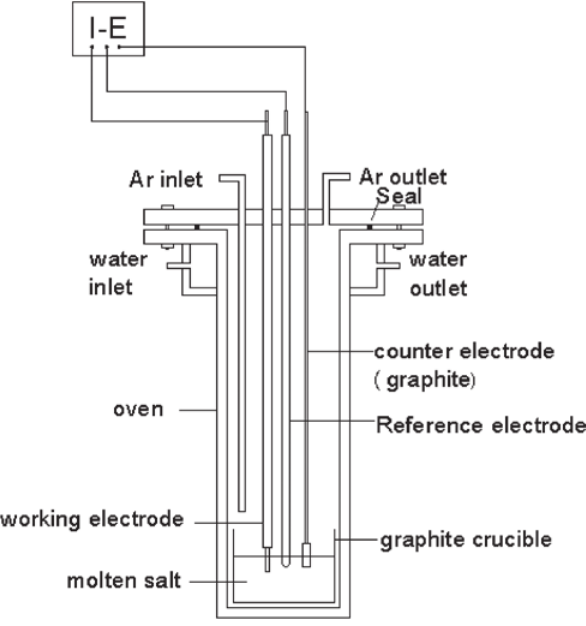
Fig. 1: A schematic diagram of experimental